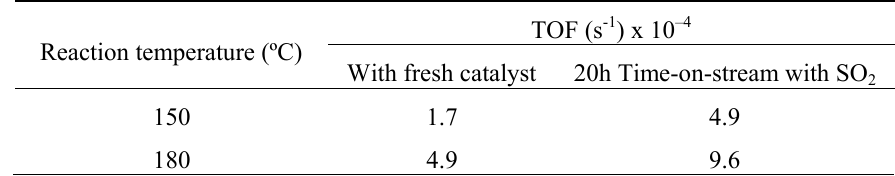
Table 5. Turnover frequency at steady state in the SCR of NO with NH addition of 400 ppm SO . From reference [57], with permission from 2